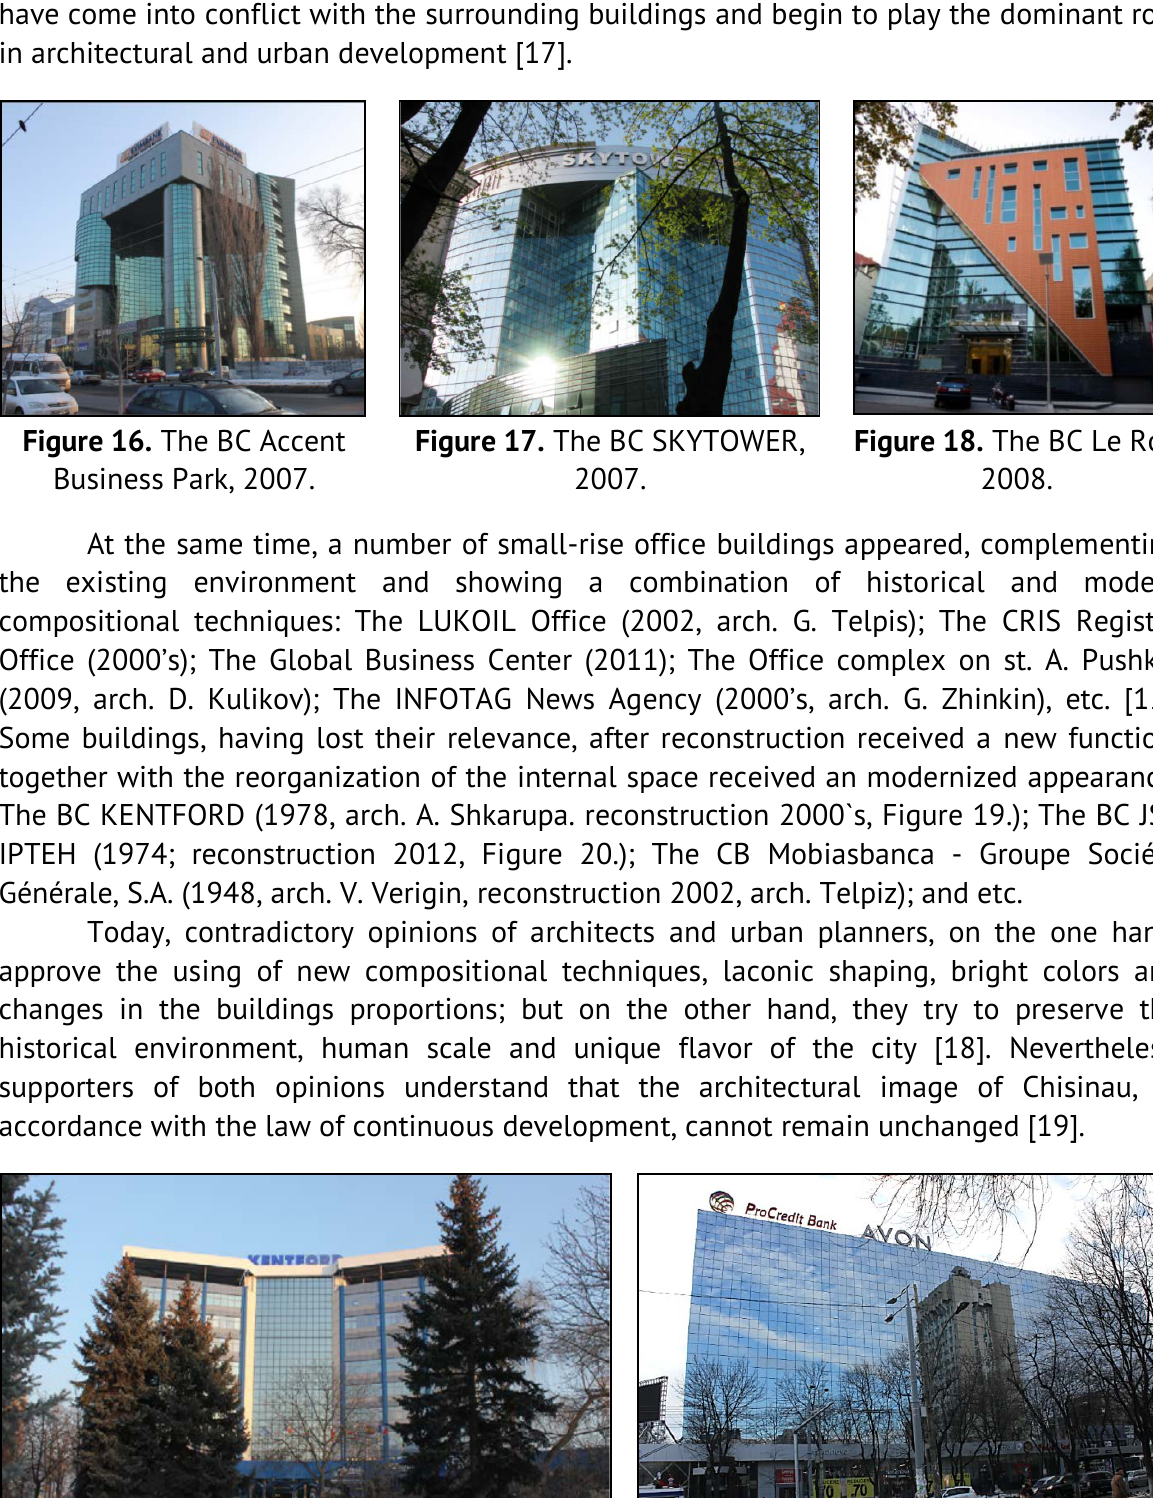
Figure 16. The BC Accent Business Park, 2007.